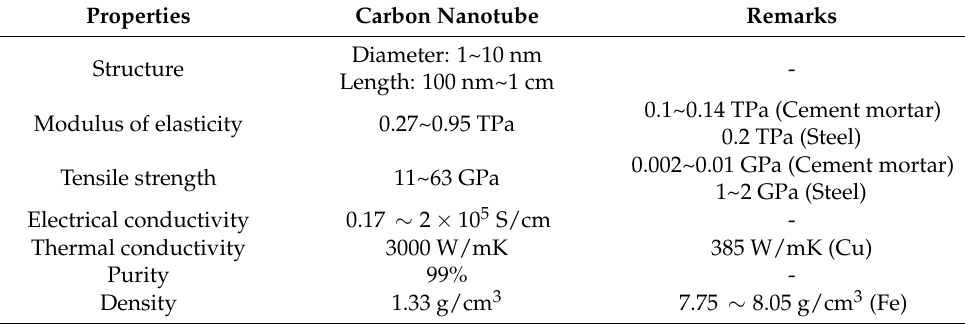
Figure 2. Test diagram: ( a ) mimetic specimen and ( b ) real specimen. Table 2. Properties of multi-walled carbon nanotubes